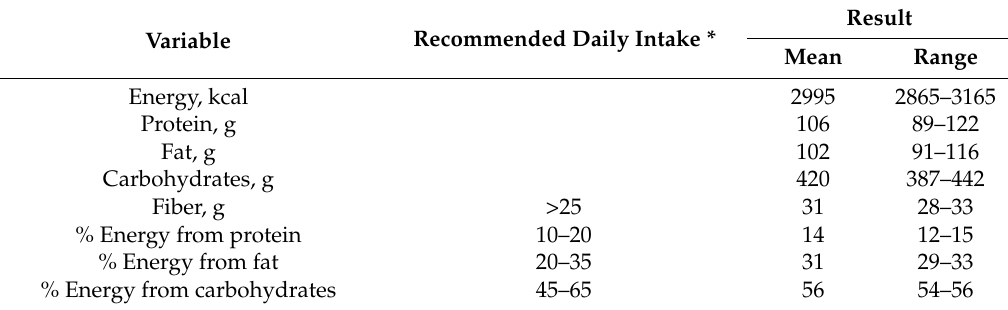
Table 1. Average daily macronutrient intake during hospital stay.